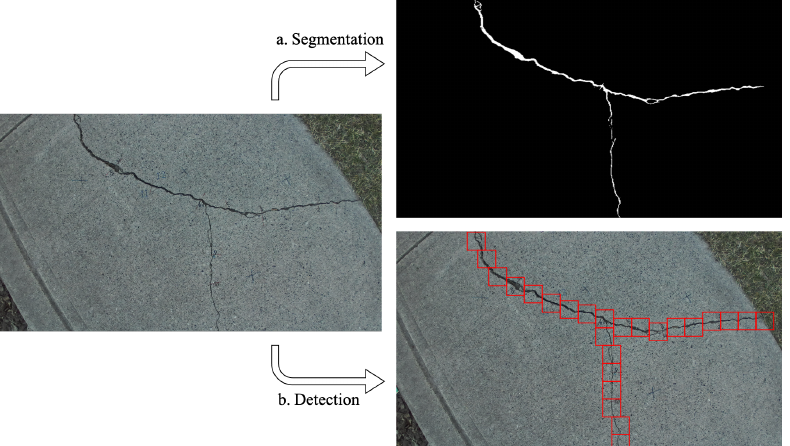
Figure 1. Illustration of semantic segmentation output mask ( a ) vs. object detection bounding boxes where a sliding window approach is used to scan the image for cracks ( b